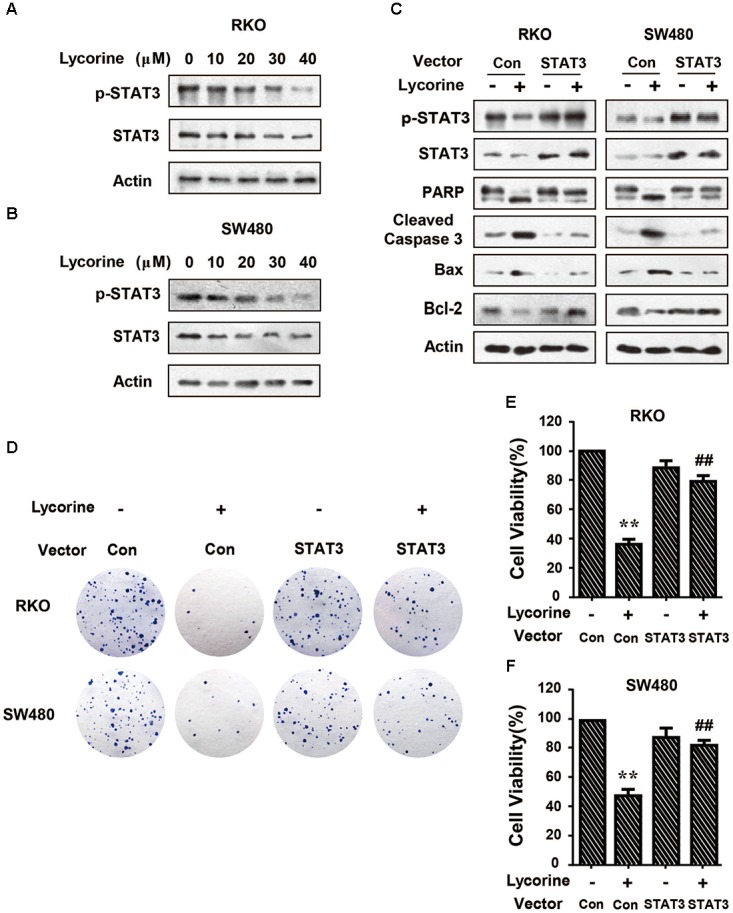
Lycorine promotes caspase-dependent mitochondrial apoptosis via STAT3 inactivation. (A,B) RKO and SW480 cells were treated with indicated concentrations of lycorine for 48 h. The protein levels of p-STAT3 were determined by Western blot assays. Total STAT3 expressions were detected as the internal control. (C–E) Cells transfected with STAT3 (STAT3 Vec) or empty vector (Control Vec) followed by lycorine treatment. (C) The protein levels of p-STAT3, STAT3, PARP, cleaved caspase-3, Bax, and Bcl-2 were detected by Western blot assays. (D) The colony formation capability was detected by colonogenic assay. (E) The cell viability was measured by MTT assay. For (E,F), data are shown as mean ± SD (n = 3); ∗∗P < 0.01 compared with Vector control; ##P < 0.01 compared with Vector control transfected cells treated with lycorine (Student’s t-test). All the western data shown are representative of at least three independent experiments.